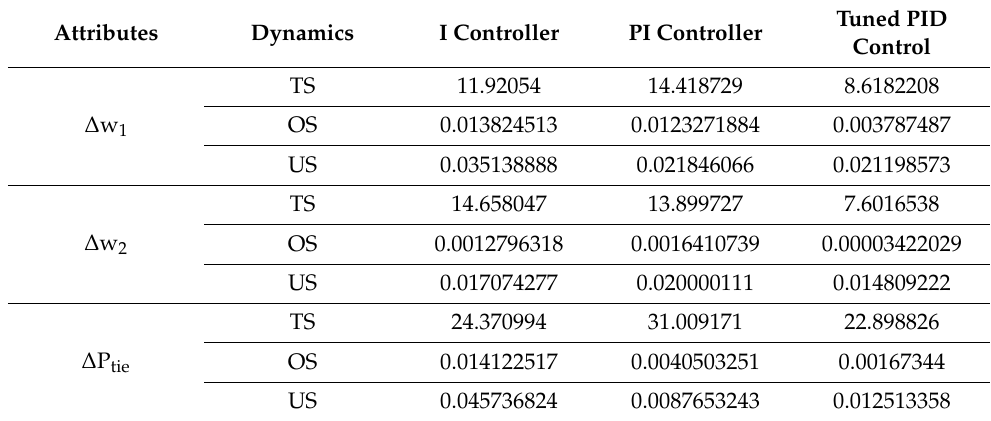
Table 8. Comparison of I and PI controllers with tuned PID for STP (Undershoot—US, Overshoot— OS, and Time to